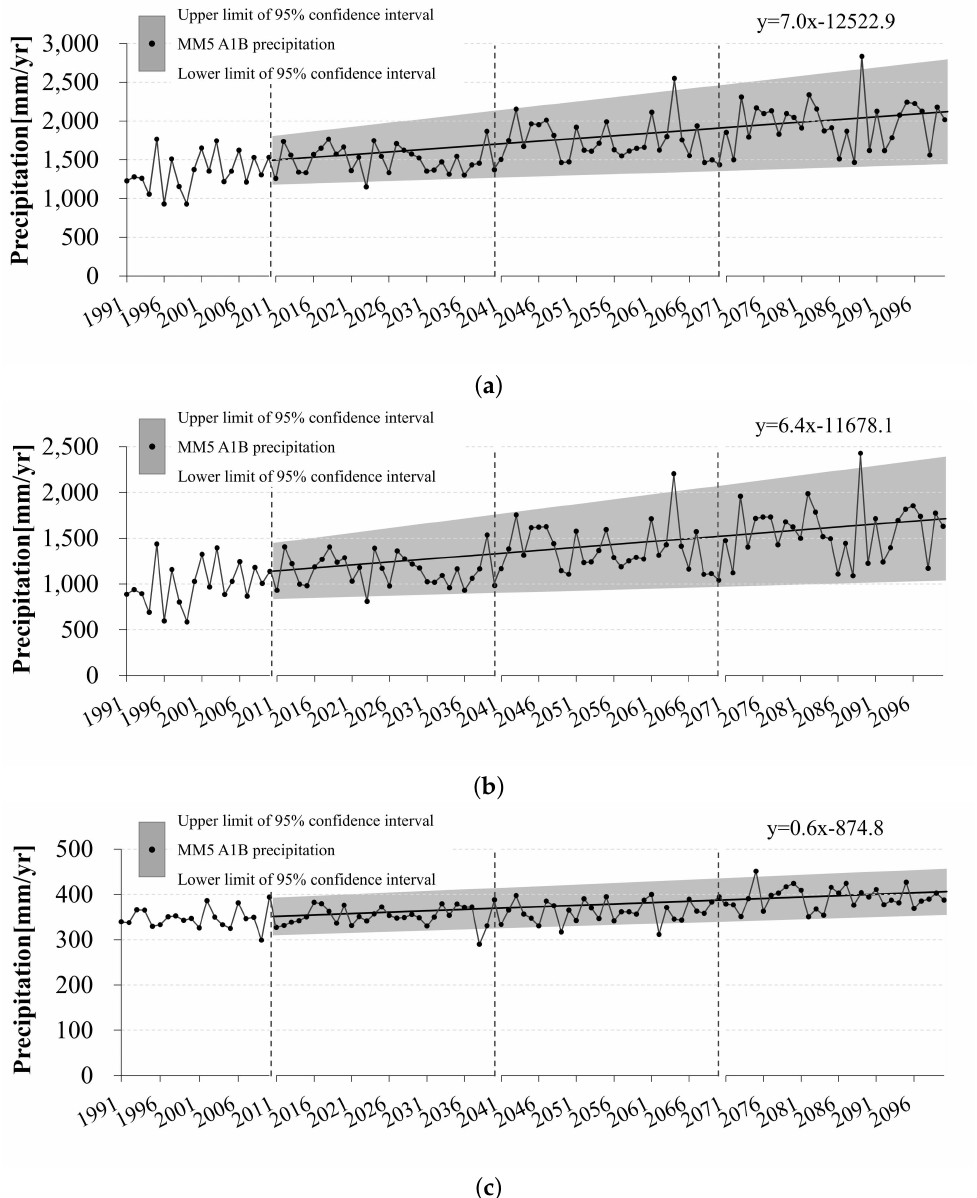
Figure 8. Projected precipitation scenario: ( a ) entire season; ( b ) flood season; ( c ) non-flood